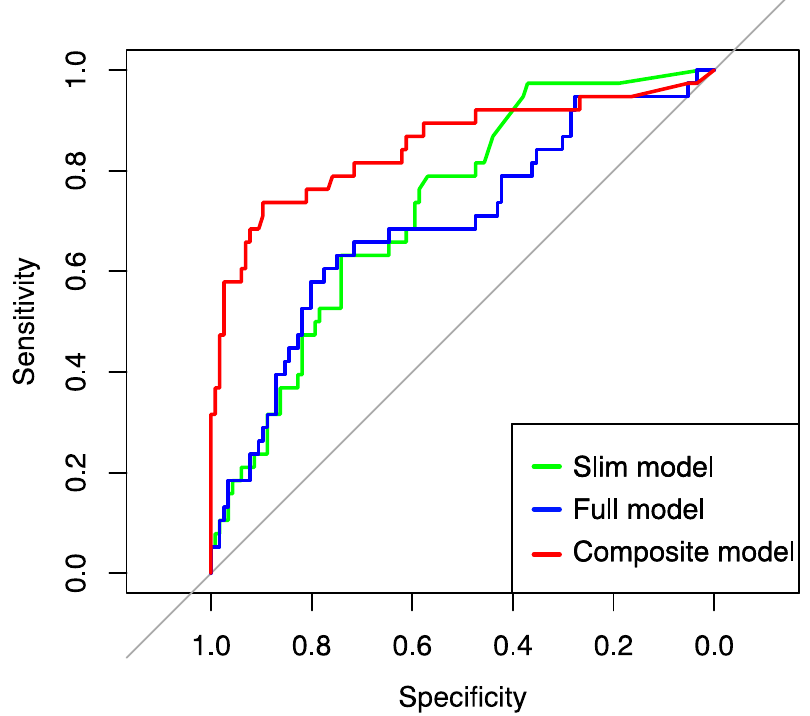
Figure 3. ROC curves for the “full” clinical factor model (blue), “slim” clinical factor model (green), and the composite imaging and “slim” clinical model. An interactive web-based